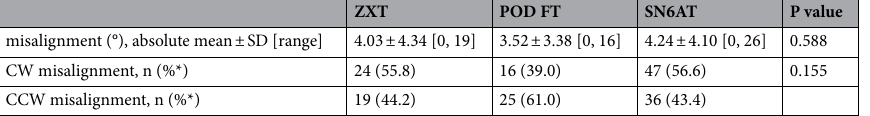
Table 2. The TIOL deviation and its direction of the different TIOLs. TIOL toric intraocular lens, CW clockwise, CCW counterclockwise. *IOLs that were precisely on the planned axis were excluded.